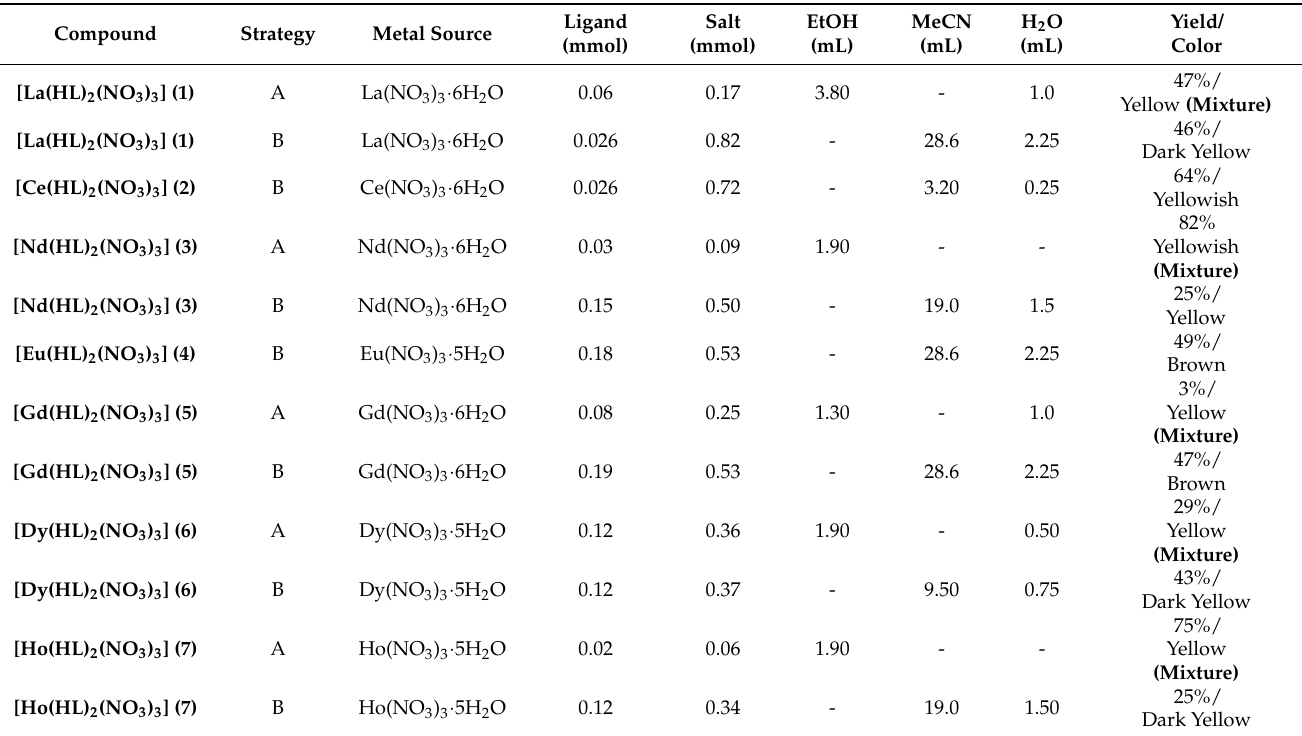
Table 2. An overview of the optimized synthesis conditions for the all [Ln(HL) 2 (NO 3 ) 3 ]. Compound